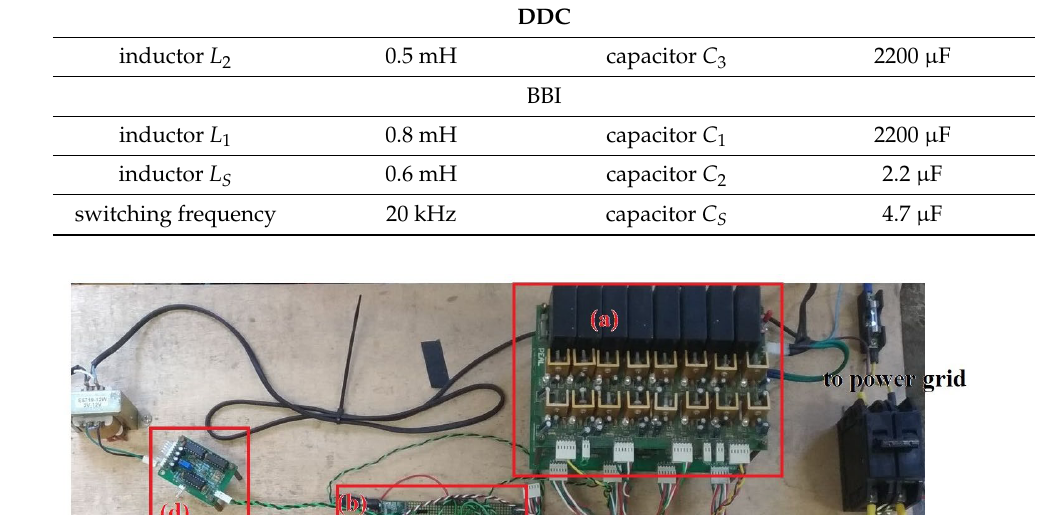
Table 2. Circuit parameters of hardware prototype.